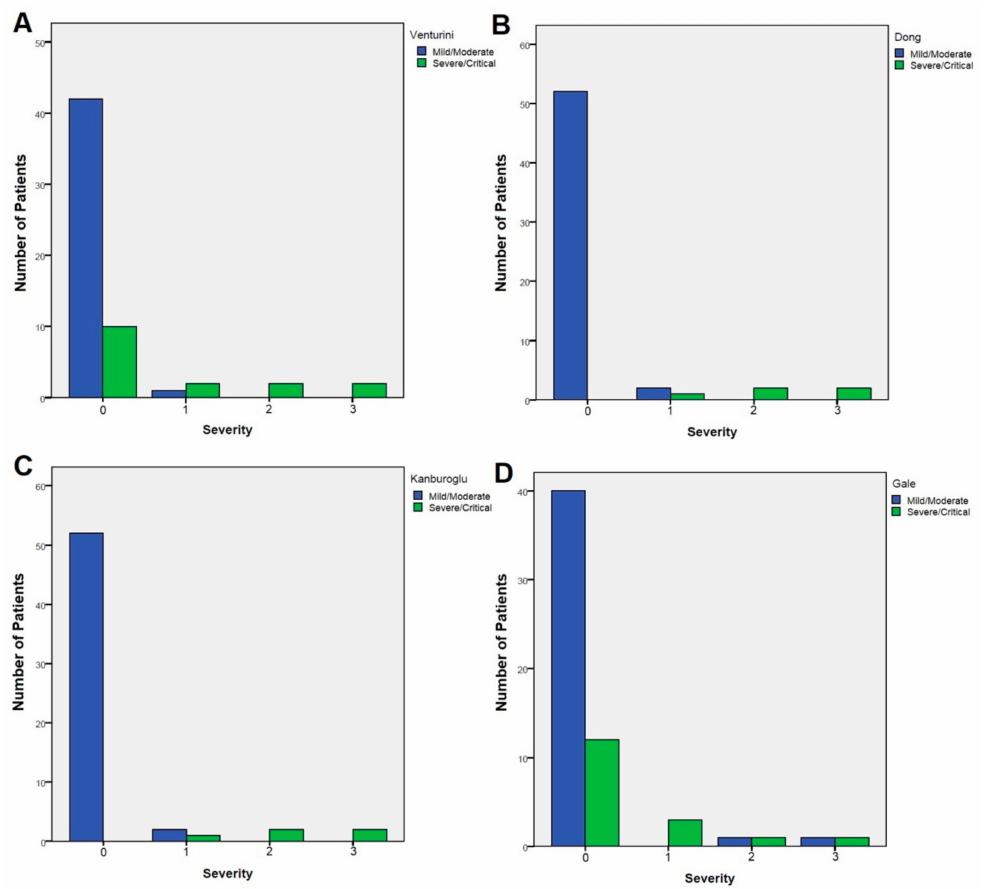
Figure 2. Distribution of patients classified as mild/moderate (blue bars) vs severe/critical (green bars) according to the Venturini ( A ) Dong ( B ) Kanburoglu ( C ), and Gale ( D ) severity classifications among the a posteriori severity score assigned to 59 subjects under 28 days of age based on their clinical presentation and